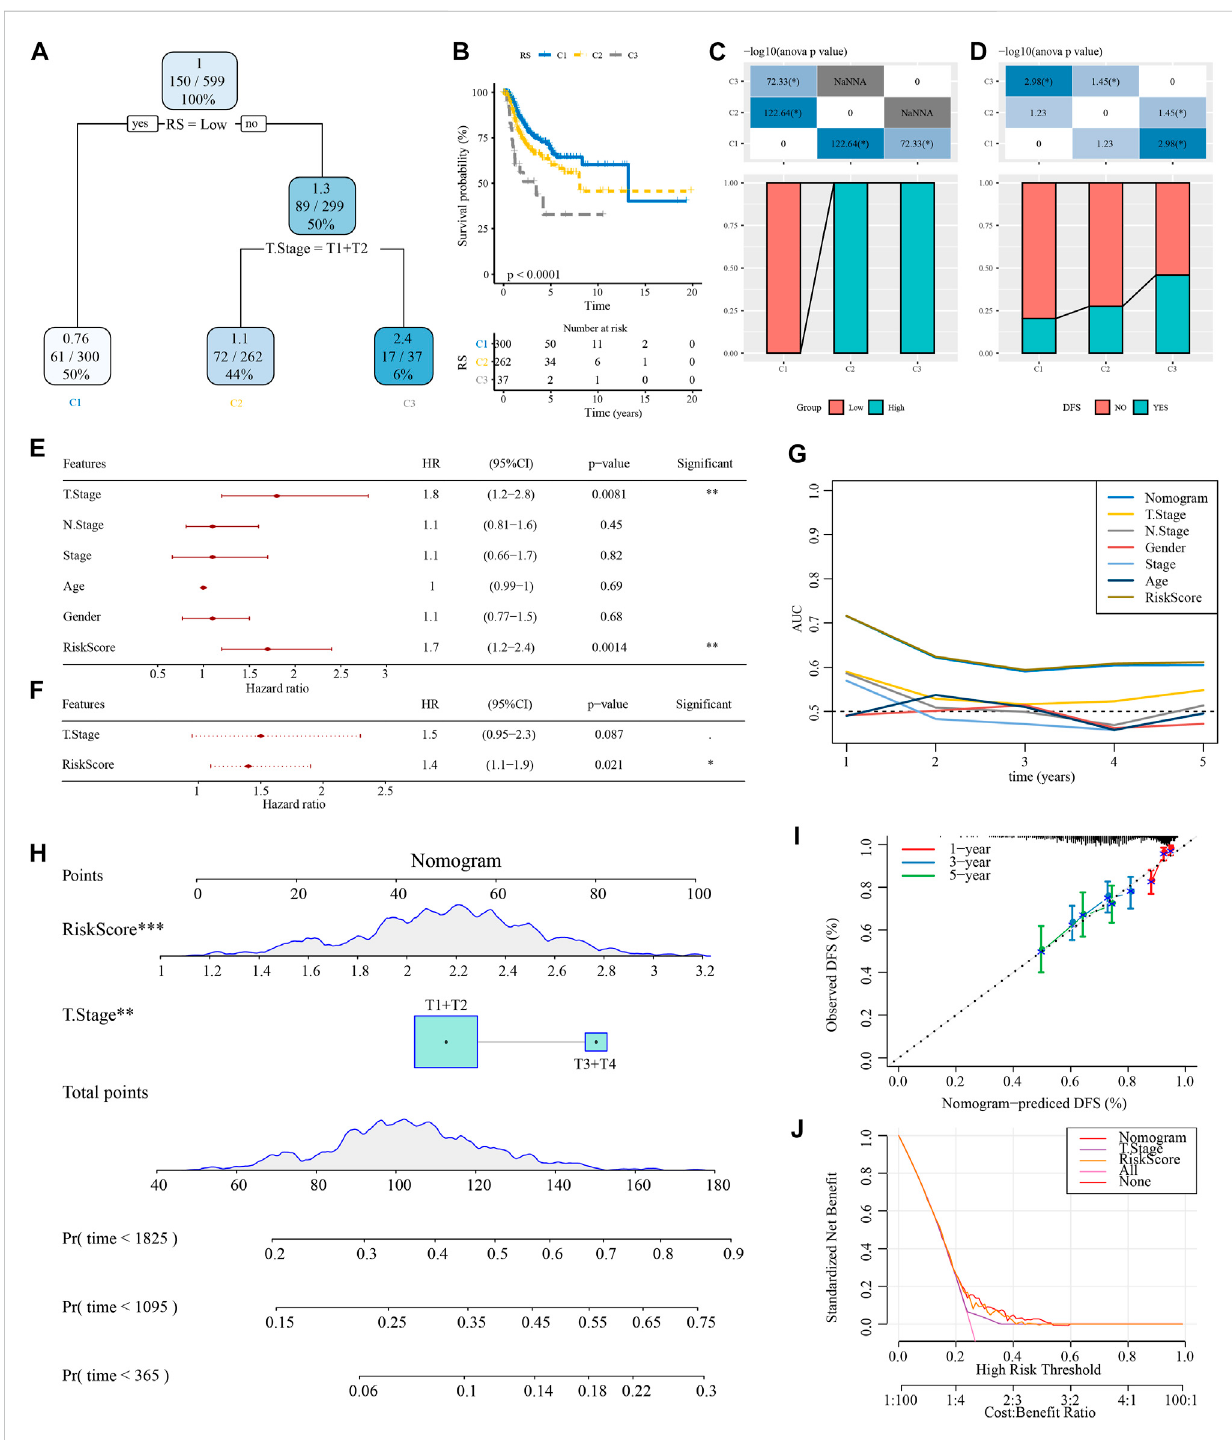
FIGURE 8 Optimization of the RiskScore model. (A) Patients with full-scale annotations including RiskScore, stage, gender, and age were used to build a survival decision tree to optimize risk strati fi cation. (B) Signi fi cant differences in overall survival were observed among the three risk subgroups. (C , D) Comparative analysis among the different groups. (E , F) Univariate and multivariate Cox analysis of RiskScore and clinicopathological features. (G) Compared with other clinicopathological features, the nomogram exhibited the most powerful capacity for survival prediction. (H) Alignment diagram showing the in fl uence of different factors on the prediction results; the top panel shows scores, the middle panel shows different factors, and the bottom panel shows predictive ef fi ciency. (I) Calibration curves of the 1, 3, and 5 years of the line chart. (J) Decision curve of the line